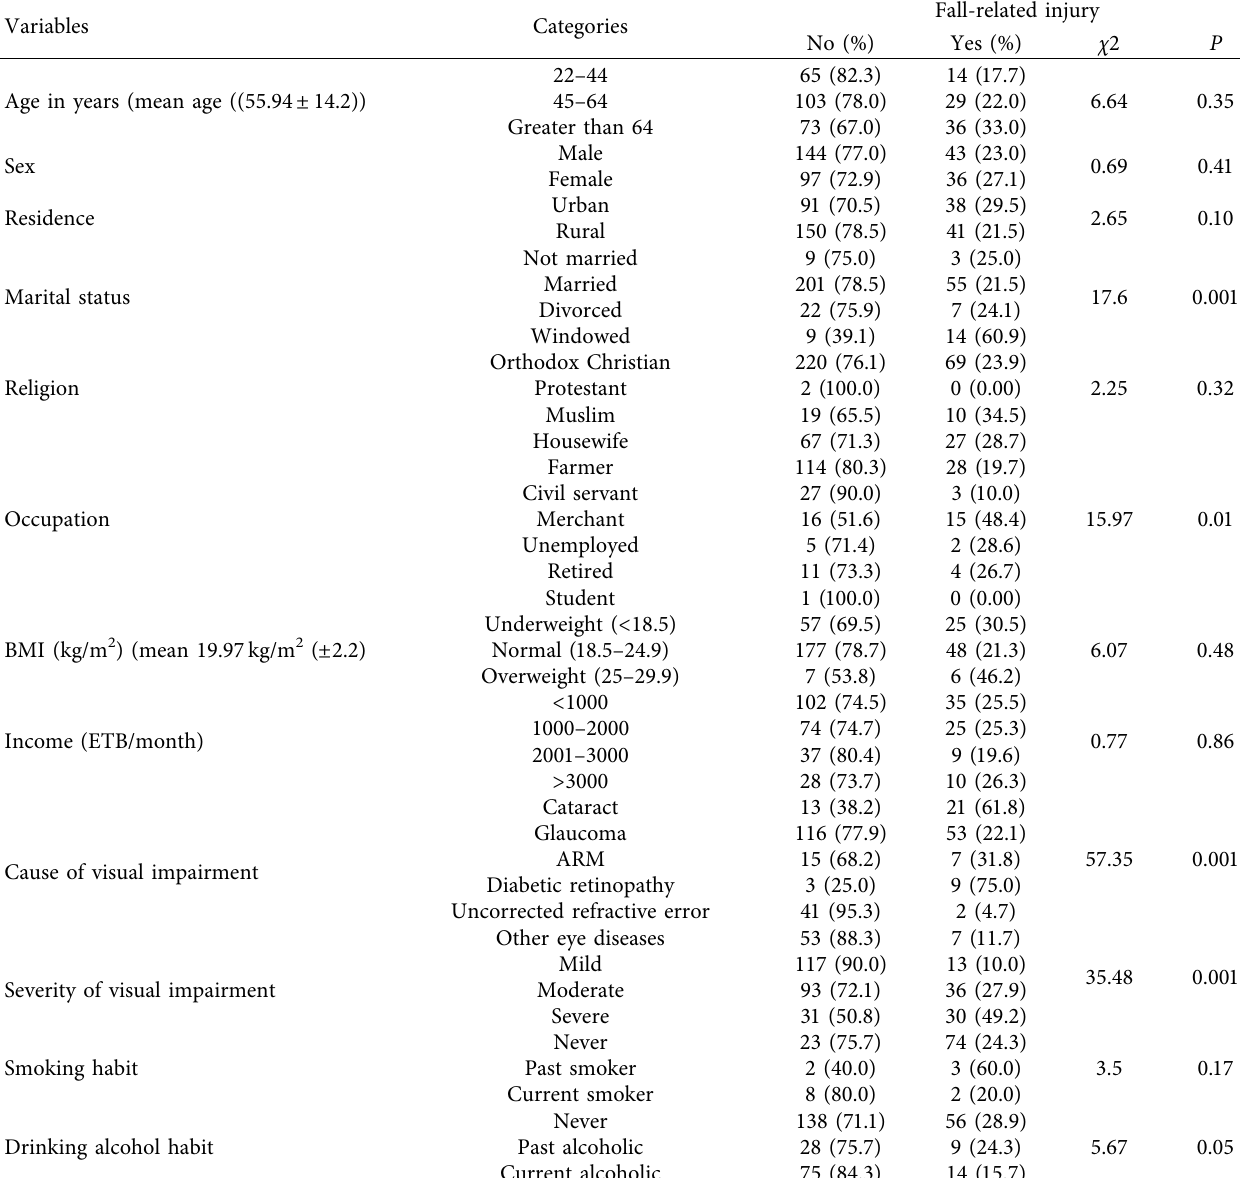
Table 3: Fall-related injuries among medically diagnosed adults with visual impairments, Gondar, Ethiopia ( n � 320).